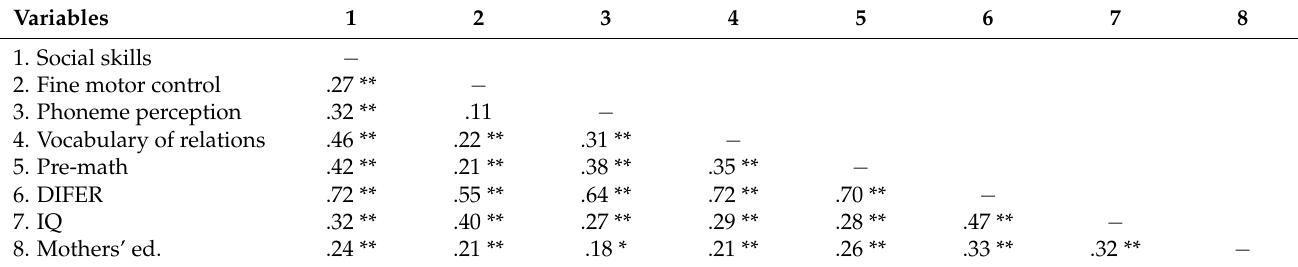
Table 2. Intercorrelations of the Independent Variables (Preschool).